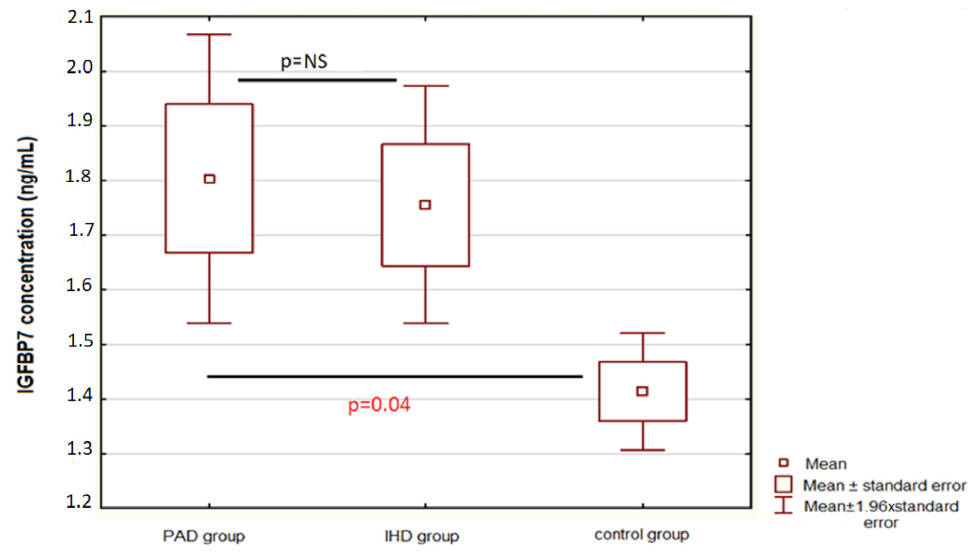
Figure 1. Comparisons between patients with PAD, IHD, and the control group according to the IGFBP-7 concentration. Abbreviations: IGFBP7—insulin-like growth-factor-binding protein 7, IHD—ischemic heart disease, PAD—peripheral artery disease. Patients with multilevel peripheral artery disease presented significantly higher IGFBP-7 concentrations than patients with aortoiliac occlusive disease—median 1.18 ng/mL (IQR 0.48–2.23) vs. 1.42 ng/mL (0.71–2.63), p = 0.035. There were no statistical dif- ferences in the rest group of patients—Figure 2.